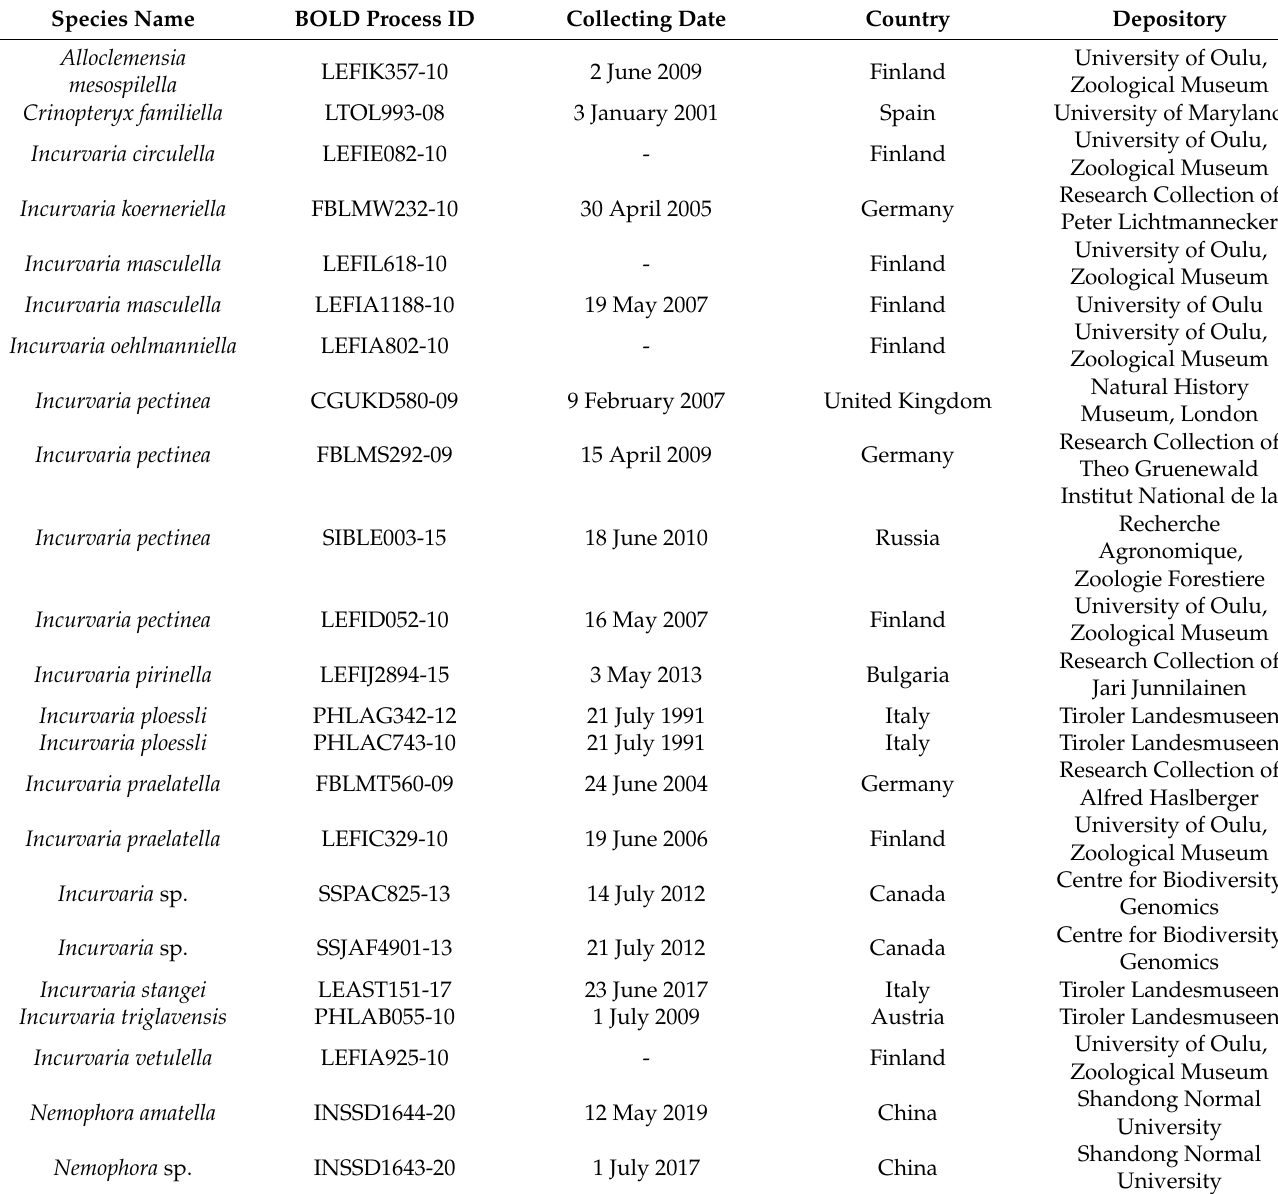
Table 1. Specimens and DNA barcode sequences used in the molecular